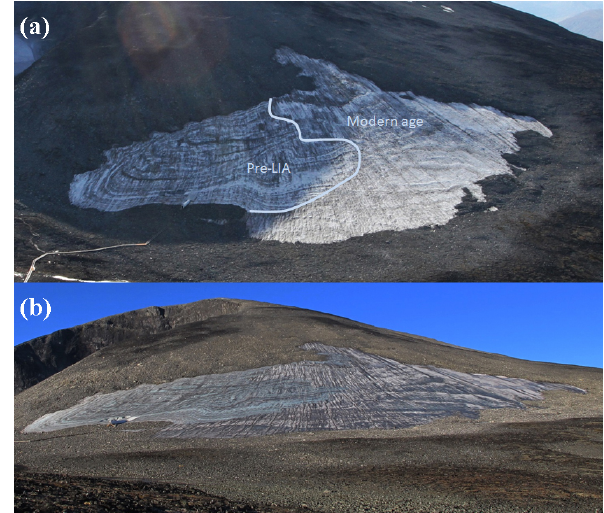
Figure 6. Photos of Juvfonne on 17 September 2014 (a) and 10 September 2014 (b) showing the pre-LIA surface exposed in the central and southern parts of the ice patch (left side). The area on Juvfonne in the north-west (right side) is interpreted to be ice of modern age. The entrance of the ice tunnel sits on a small ridge that might be ice cored (left side, lower image). The collapsed 2010 tunnel is to the left of the entrance. Photo: Glacier Archaeology Program, Oppland County Council (upper) and L. M. Andreassen (lower).